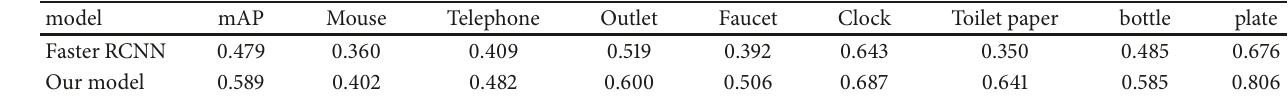
Table 4: The comparison of accuracy between our model and Faster-RCNN. (40000,20000). model